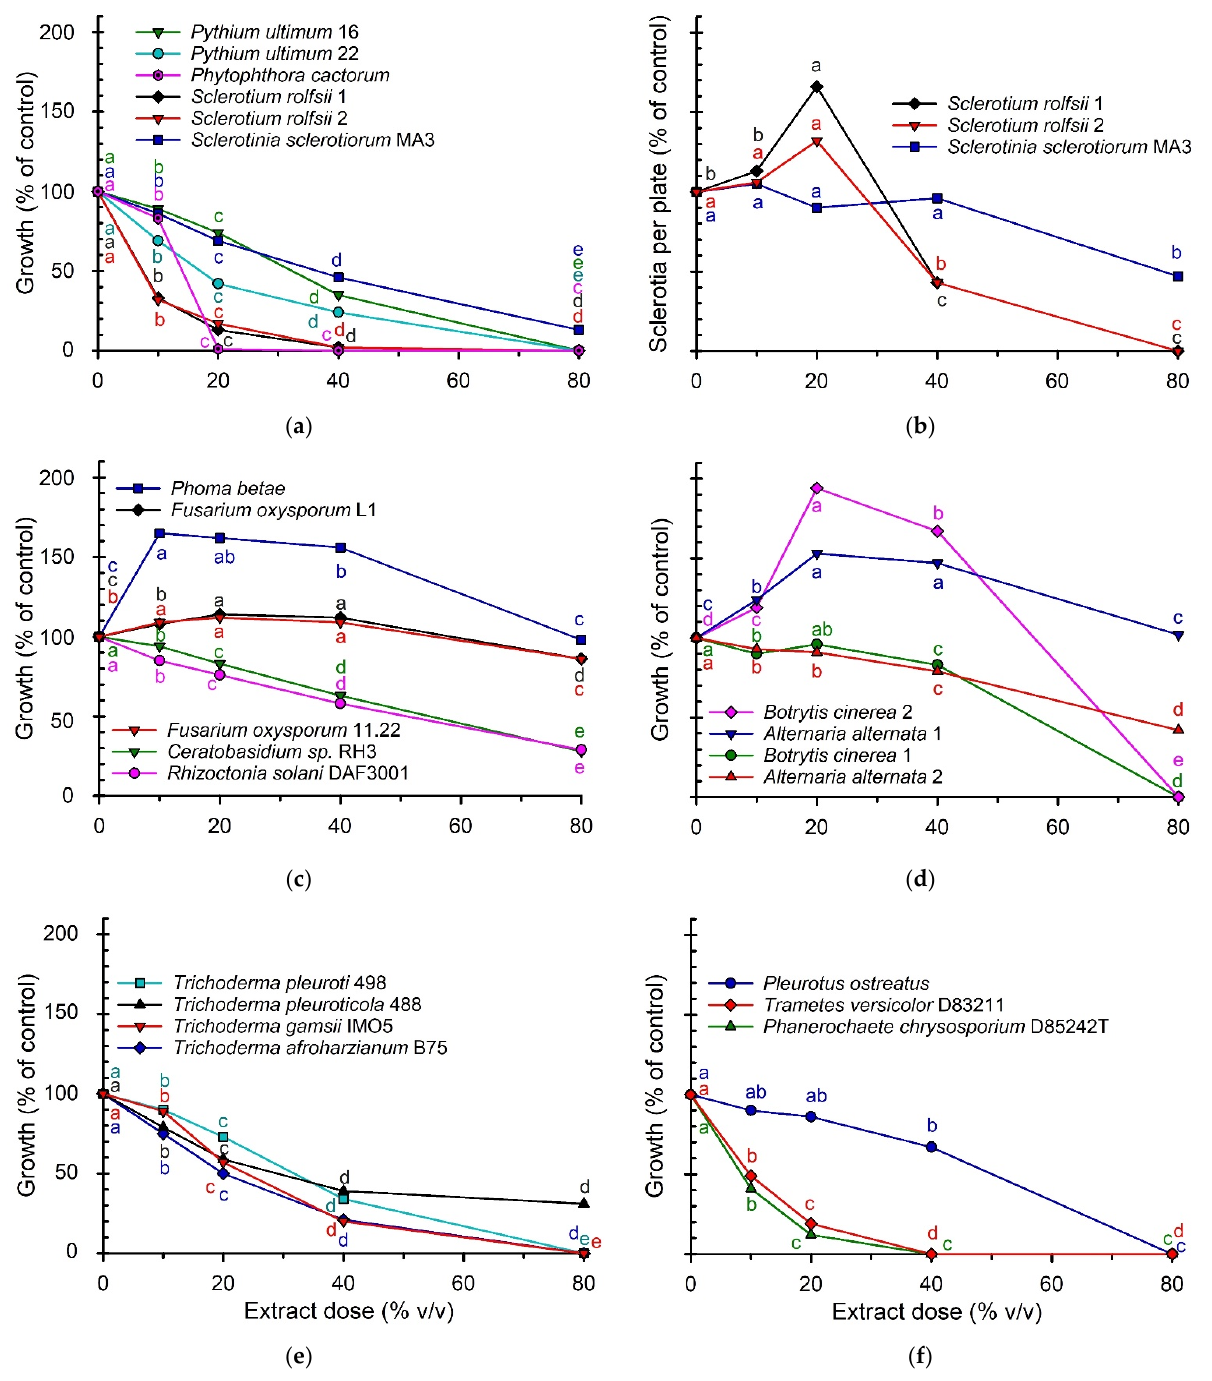
Figure 3. Screening of a collection of fungi and oomycetes for sensitivity to the giant reed extract in PDA plates amended with increasing doses of the extract (% volume/volume, v / v ). Colony growth of ( a , c ) soilborne pathogens; ( d ) airborne fungi; ( e ) pathogenic and nonpathogenic Trichoderma spp.; ( f ) wood decay fungi. Panel ( b ) shows the sclerotia production by Sclerotium rolfsii and Sclerotinia sclerotiorum . Both the parameters (i.e., colony growth and number of sclerotia per plate) are expressed as a percentage of the control (0% dose). For each isolate, mean values sharing the same letter were not different at p < 0.05 according to Tukey’s test after one-way ANOVA ( n = 3). See also Tables S1 and S2 in the Supplementary Materials reporting mean and standard deviation values.